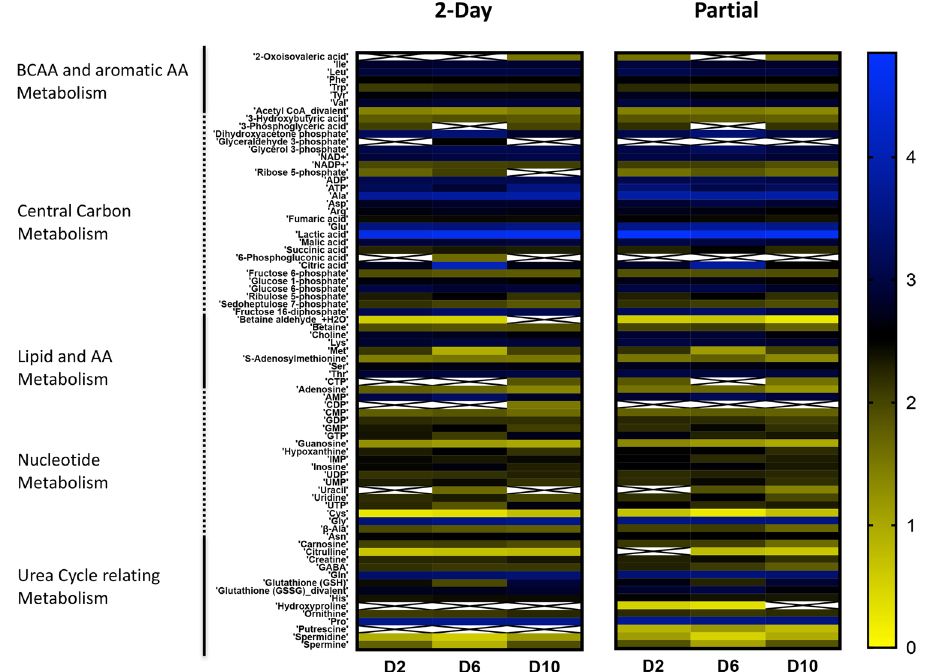
Figure 6. Effect of altered media change protocols on the metabolic fingerprint of the gut MPS. Intracellular metabolite concentrations were quantified for a 2-day media change (left panel) and partial media change (right panel) protocol for the gut MPS at days 2 (D2), 6 (D6) and 10 (D10). Metabolites were grouped according to involvement in particular pathways. Changes in metabolites over time appear to be similar between the media change protocols. Crossed boxes indicate no measurements. The colorbar indicates log2-transformed concentration